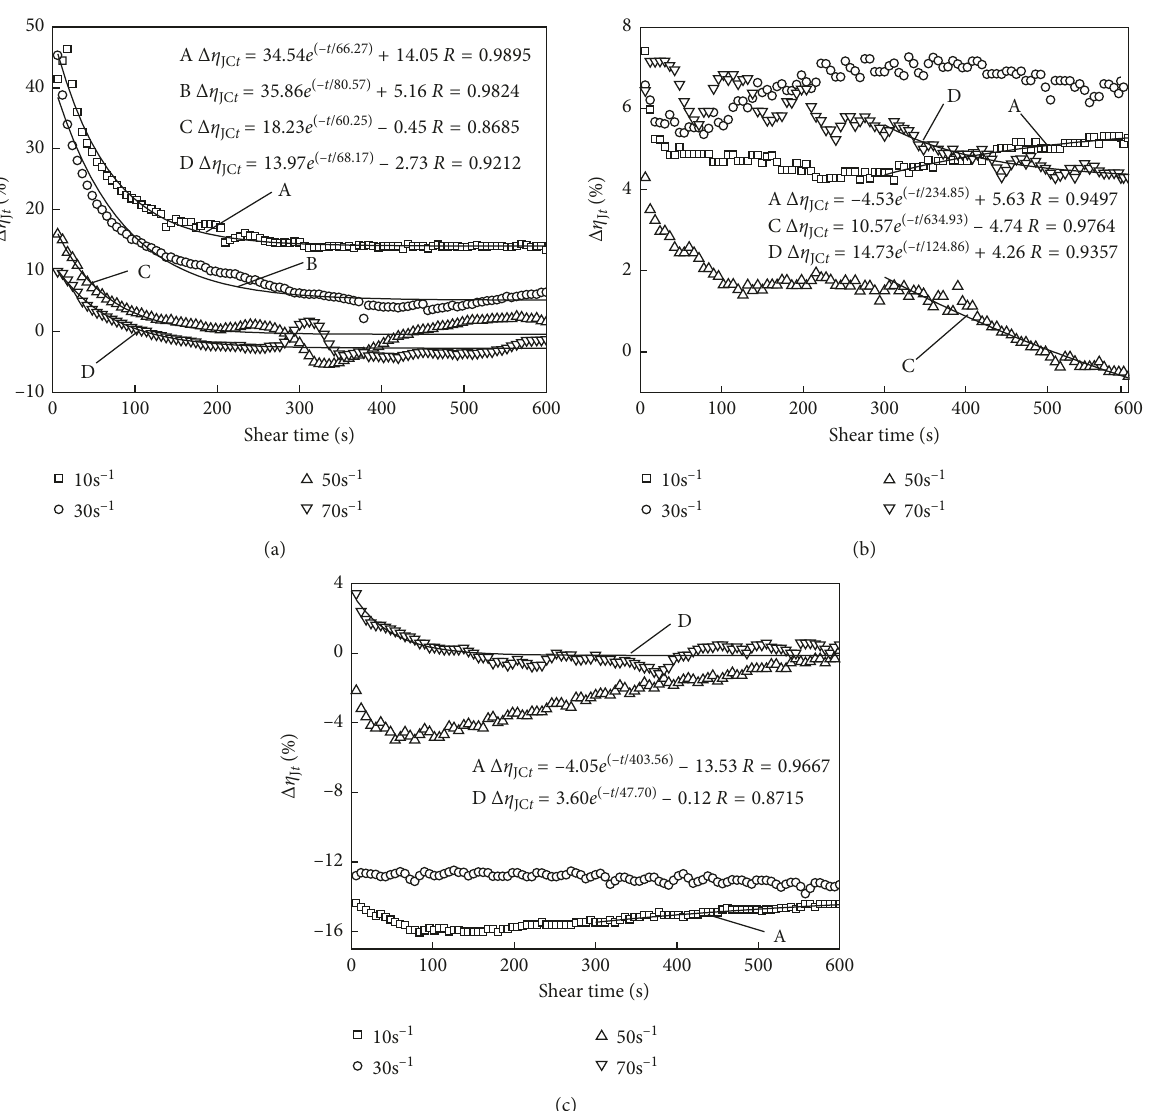
with shear time: (a) FTS; (b) UTS; (c) JC t